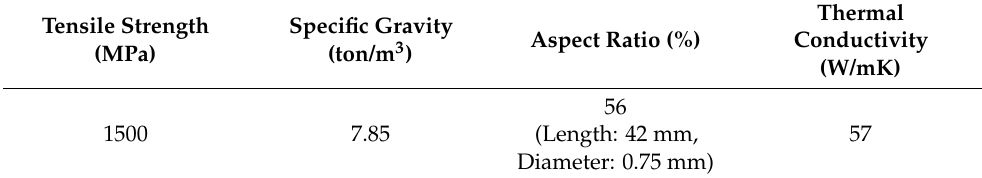
Table 4. Properties of steel